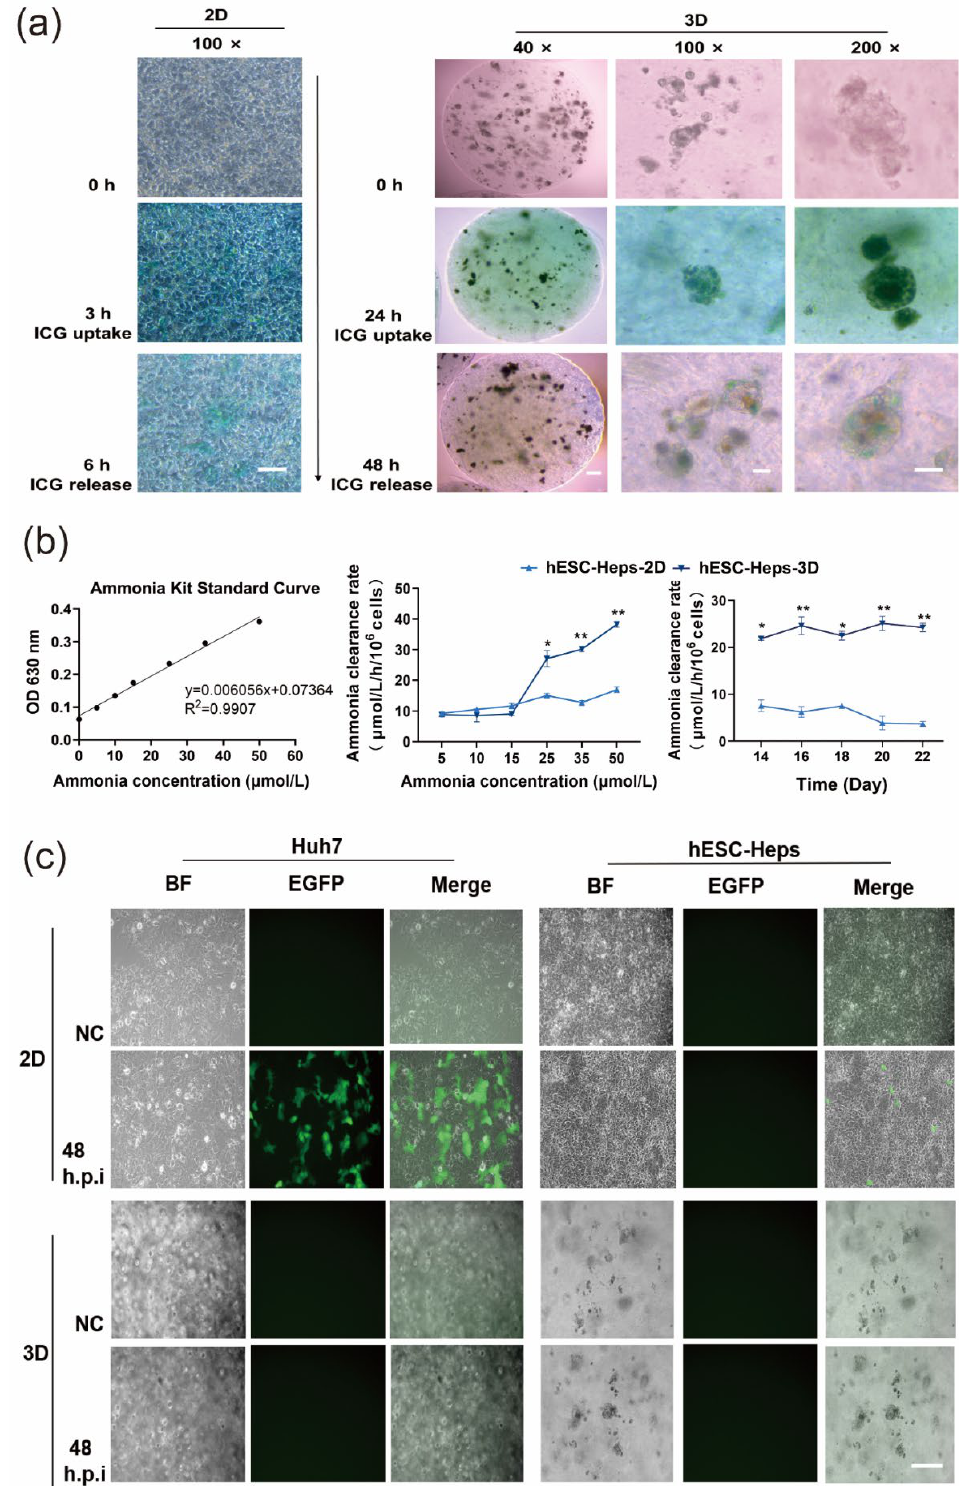
Figure 4. Characteristics and functionalities of hESC-Heps in 3D microsphere culture. ( a ) Indocyanine-green uptake and release by hESC-Heps. ( b ) Ammonia scavenging capacity of 2D hESC-Heps vs. 3D hESC-Heps. ( c ) Infection of Huh7 and hESC-Heps in microspheres following infection with VSVG-pseudotyped lentivirus encoding EGFP for 48 h. Infected cells show green fluorescence (NC, negative control). Data are the mean ± SD (n = 3) and analyzed by Student’s t test. * p < 0.05, ** p < 0.01. Scale, 100 μm.